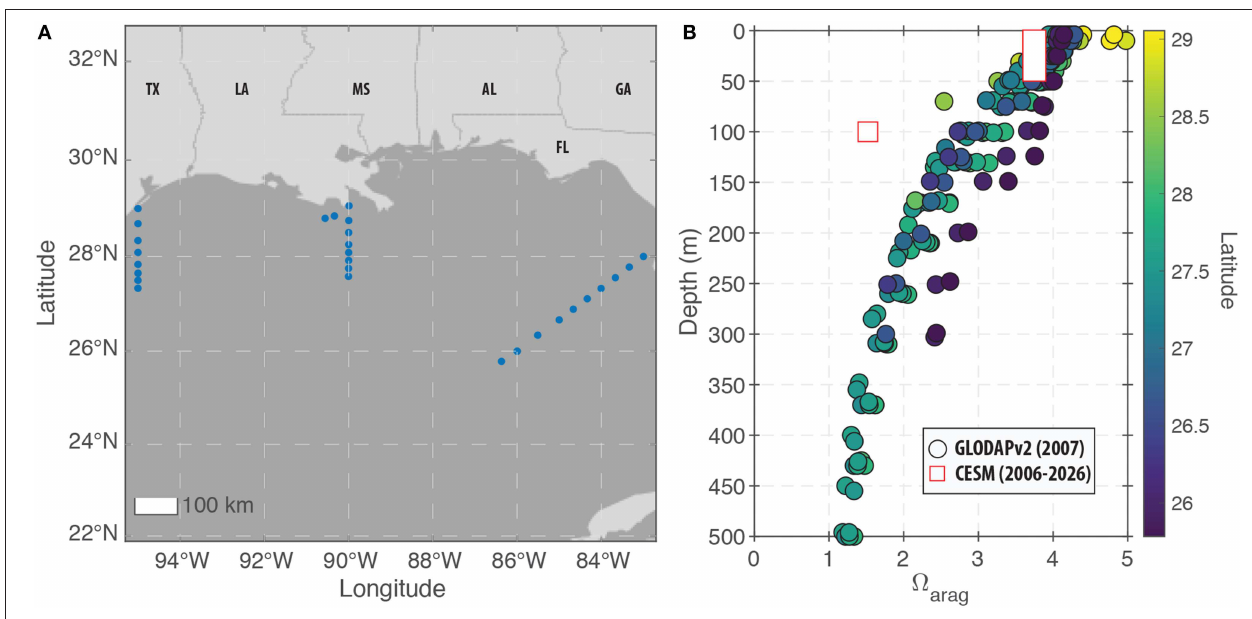
FIGURE 7 | Modern observations of carbonate chemistry in the GoM. (A) Map showing the locations of the GLODAPv2 stations within the GoM that are used for comparison to the CESM predictions. The displayed region (83 ◦ W to 95 ◦ W and 22 ◦ N to 33 ◦ N) defines the GoM region used for displaying the model predictions in (B) as well as Figure 10 . (B) Field measurements (circles) and model predictions (squares) of changes in (cid:127) aragonite with depth in the GoM. For the surface ocean (0–50 m), the model reproduces most of the data with the exception of the highest latitude sites. However, at 100 m water depth, the model under-predicts (cid:127) aragonite relative to all of the field